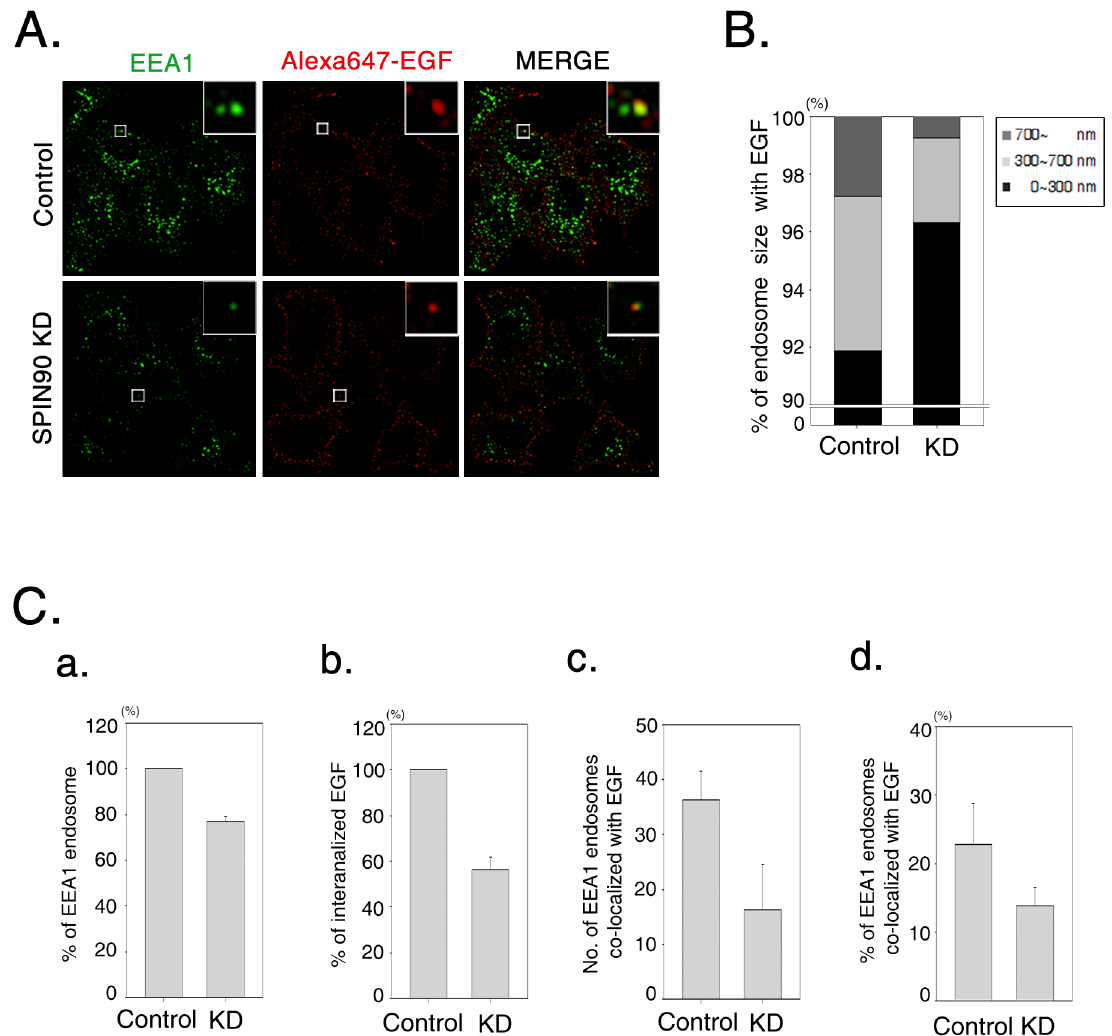
Figure 4. SPIN90 knockdown suppresses the formation of EEA1-positive endosomes. A. Cells were treated with Alexa Fluor 647- conjugated EGF (40 ng/ml) for 10 min and fixed, prior to immunostaining with anti-EEA1 antibody. B. Bar graphs were generated using Sigmaplot. In total, 120 – 170 endosomes per cell were measured using three criteria (vesicle width: 0 – 300 nm, 300 – 700 nm and . 700) in 60 control and SPIN90 knockdown cells (KD). Overall, 150.70 6 5.82 vesicles (91.89%) in control cells and 121.36 6 7.65 (96.32%) vesicles in SPIN90 knockdown cells (KD) were 0 – 300 nm in width; 8.77 6 2.34 (5.35%) in control cells, 3.69 6 0.16 (2.93%) in KD cells were 300 – 700 nm in width; 4.53 6 0.67 (2.76%) in control cells, 0.93 6 0.16 (0.74%) in KD cells were over 700 nm in width. C. Total numbers of EEA1 endosomes (a), internalized EGF (b), and numbers of EEA1- endosomes containing EGF (c) were analyzed in control and SPIN90 knockdown HeLa cells. All values were determined using Metamorph Software.